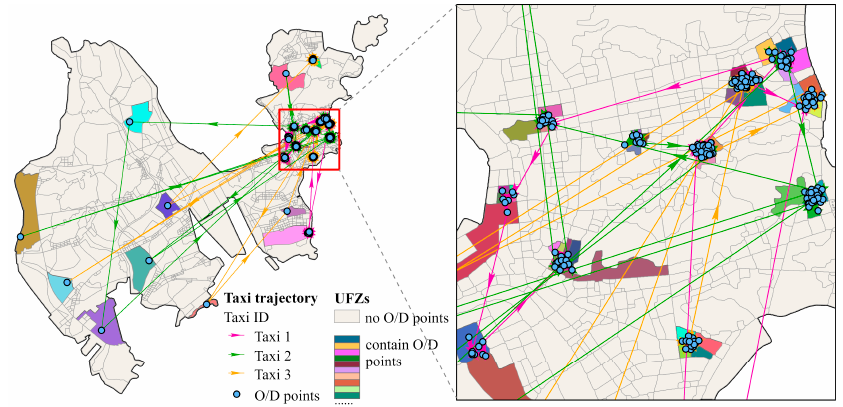
Figure 11. Sampled taxi trajectories in